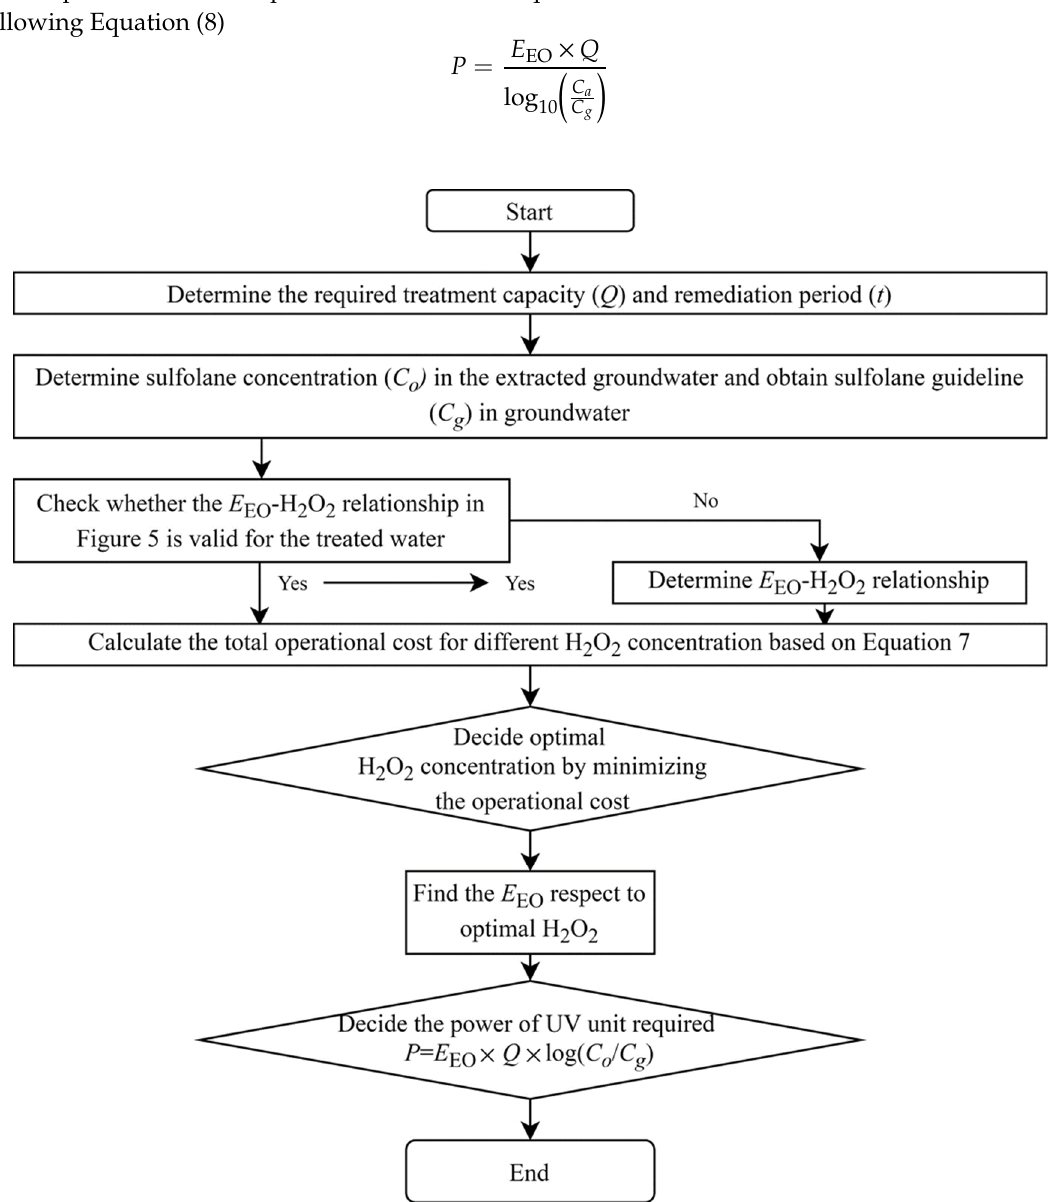
/ H 2 O 2 treatment